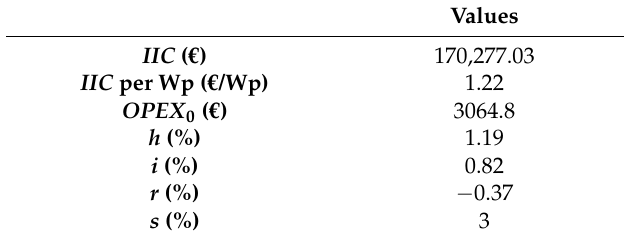
Table 10. Economic data for the Alter do Ch ã o PV-diesel drip irrigation system.